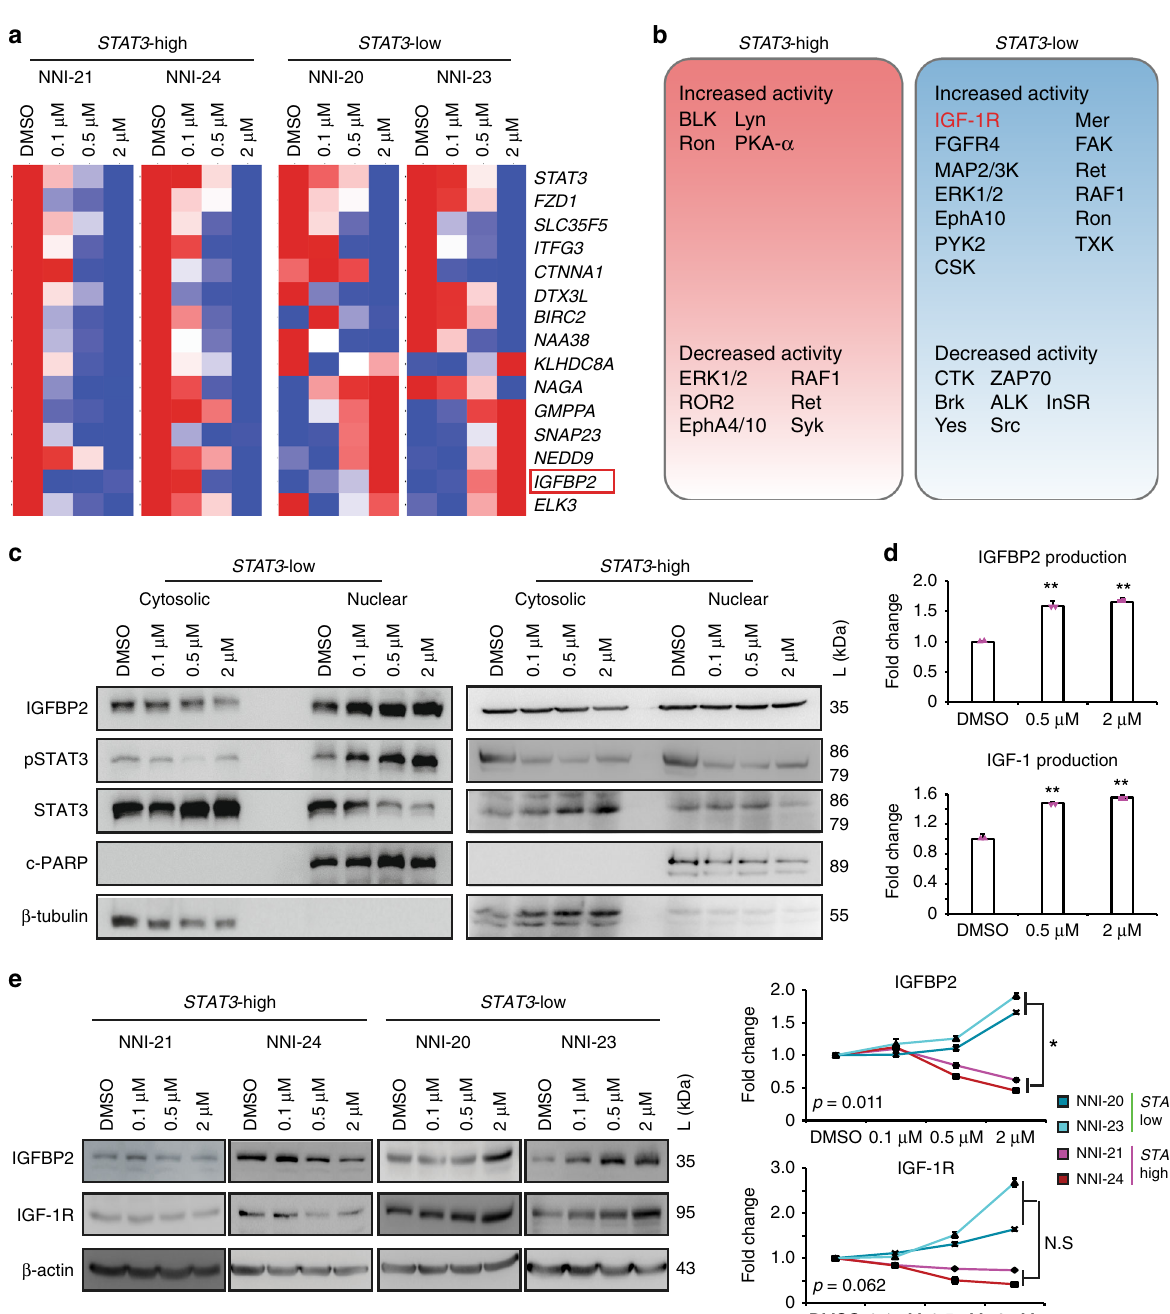
Fig. 3 Mechanistic gene candidates identi fi ed by NNI- STAT3 gene signature. a Winnowed gene list across patient tumors identi fi ed candidates uniquely upregulated in STAT3 -high tumors. A dose-dependent differential gene expression after signal transducers and activators of transcription 3 (STAT3) inhibitor AZD1480 treatment distinguished cooperative genes responsible in the STAT3 -resistant pro fi le. Results are mean of triplicate experiments. b Graphical illustration of responsive and resistant protein tyrosine kinase candidates in STAT3 -high and -low cell lines treated with AZD1480 using computational work fl ow described in Supplementary Fig. 4c. c Treatment of cells with STAT3 inhibitor (AZD1480) demonstrated an increase in pSTAT3 and insulin-like growth factor binding protein 2 (IGFBP2) expression levels in the nuclear fraction of STAT3 -low cells but not in STAT3 -high. d Fold change differences in secreted proteins demonstrated increased IGFBP2 and insulin-like growth factor 1 receptor (IGF-1R) in resistant cells post-treatment with STAT3 inhibitor. Results are mean of triplicate experiments. e STAT3 -high glioblastoma (GBM) cells displayed modest reduction in IGF-1R and IGFBP2 expression levels. In contrast, IGF-1R and IGFBP2 protein expression in STAT3 -low cells increased dose-dependently upon AZD1480 treatment, albeit IGF- 1R was marginally insigni fi cant. Fold change differences in protein expression of IGFBP2 and IGF-1R were compared between STAT3 -high and -low GBM cells. * p < 0.05; ** p < 0.01; STAT3 -high versus STAT3 -low. For statistical analysis, two-sided Student ’ s t test was used. Error bars represent standard deviation of the mean